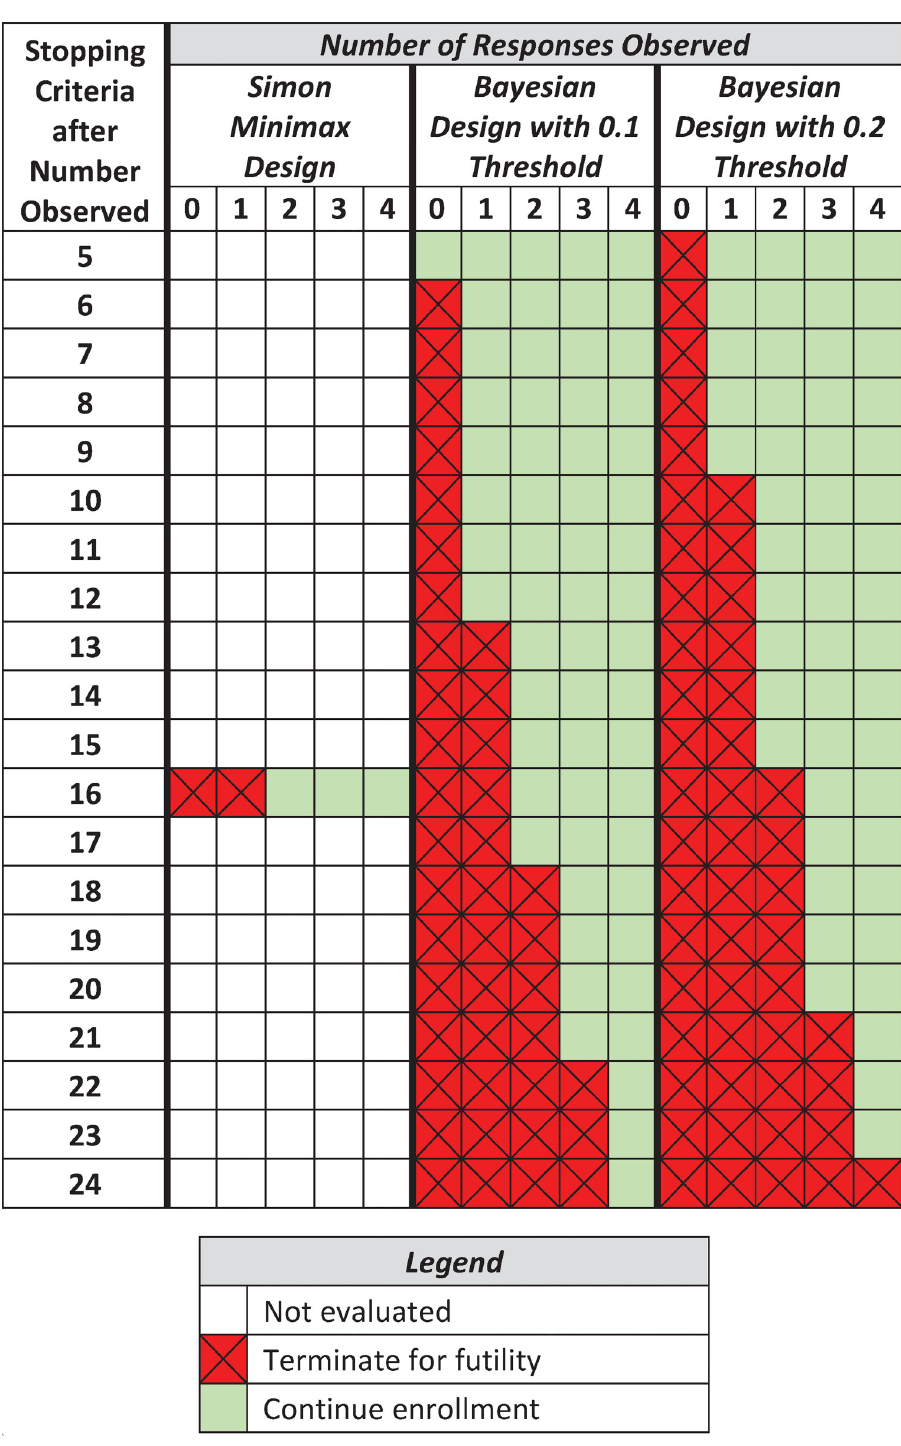
PLOS ONE | https://doi.org/10.1371/journal.pone.0272367 August 2,